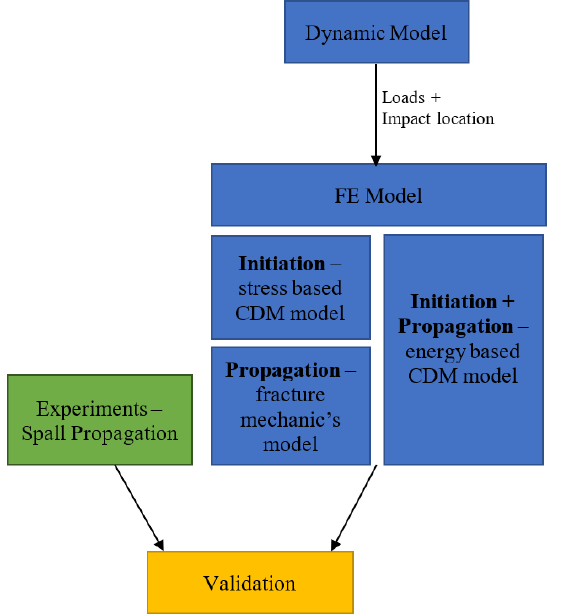
Figure 1. Research flowchart structure.